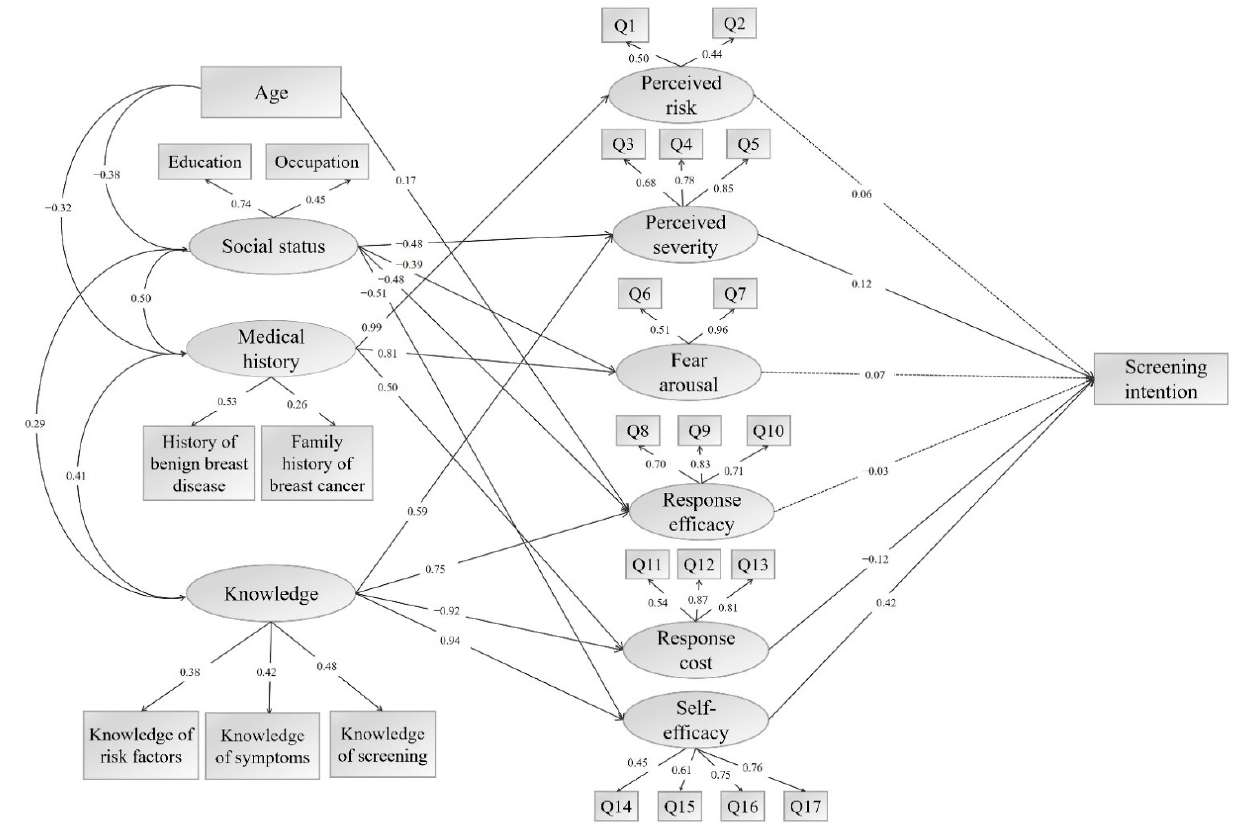
Figure 1. Results from PMT-guided SEM analysis of the factors related to screening intention. Note: Data-model fit index: GFI = 0.91, AGFI = 0.89, CFI = 0.91, RMSEA = 0.05, SRMR = 0.06, and Chi-square/df = 2.01. The latent variables are represented by ovals, while the observed variables are represented by rectangles. The observed variables “Q1–Q17” represent the 17 items of the Breast Cancer PMT Scale (see Table A1). The values of the single-headed arrows indicate the standardized coefficients. A solid line indicates a statistically significant association with p < 0.05 and a dashed line indicates the association was not statistically significant.